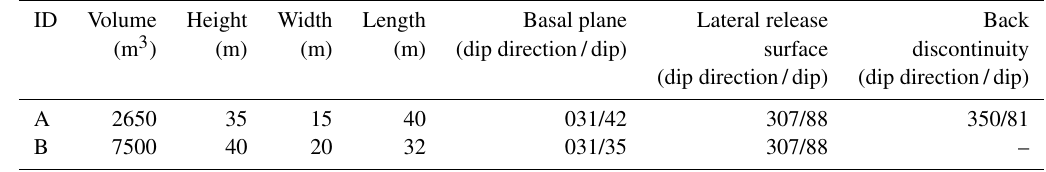
Table 6. Characteristics of identified blocks A and B.